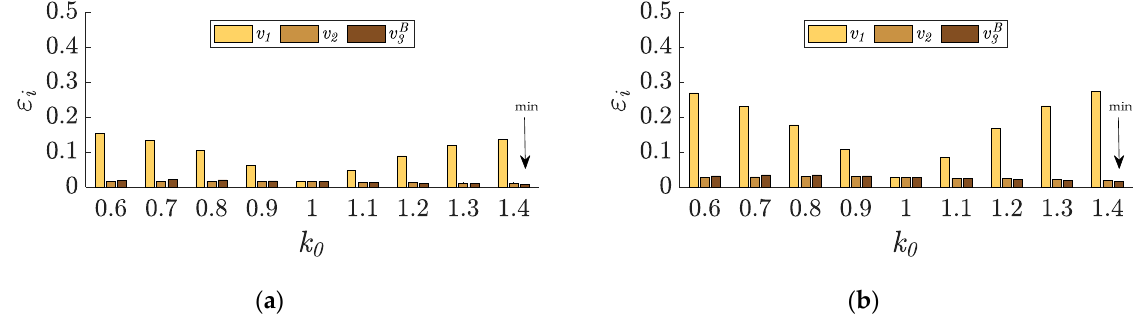
Figure 7. Error index of stator current estimation for ω m = ω mN and faulty CS in phase B : ( a ) t L = 0.25 t LN ; ( b ) t L = 0.75 t LN .